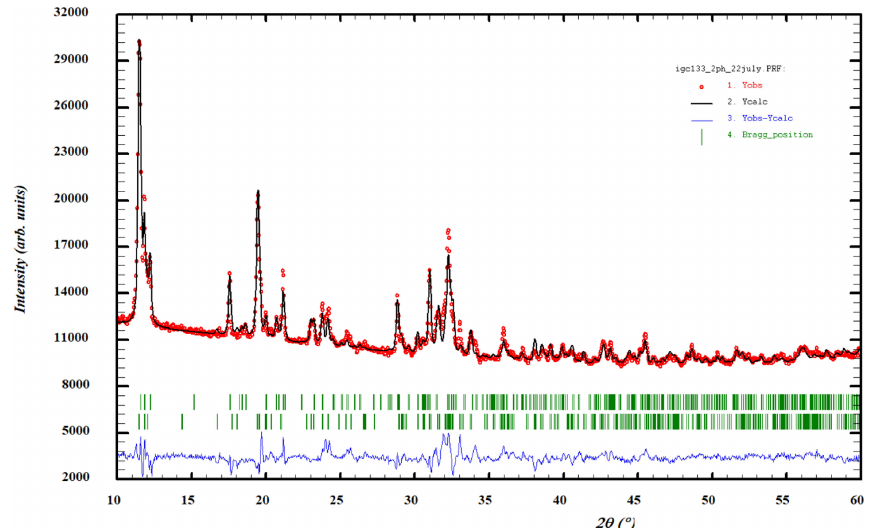
Figure 8. Rietveld profile fitting to a PXRD pattern for specimen IGC133, with a two-phase mixture of allanpringite and strunzite. Red dots represent experimental values, and the black line represents the fitted pattern. Green markers are Bragg reflections for allanpringite (upper) and strunzite (lower). Blue line is the difference plot.